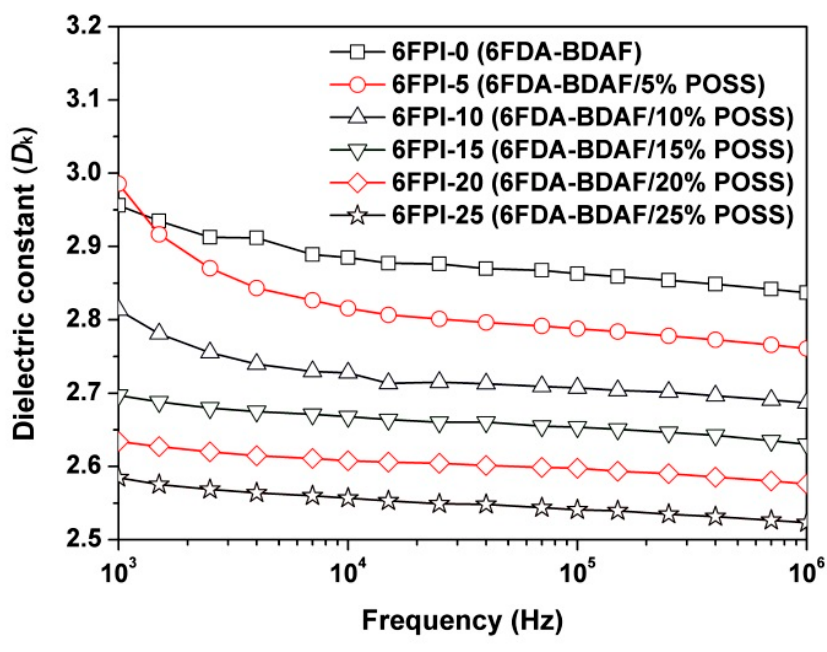
Figure 10. Dielectric parameters of 6FPI-POSS composite films.